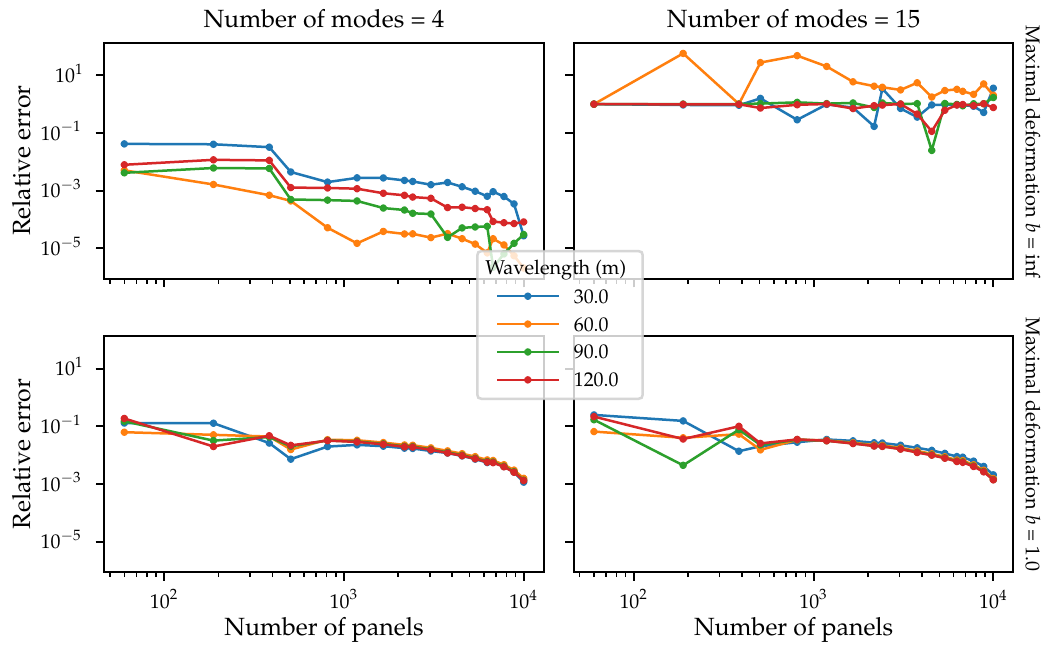
Figure 3. The relative error on the maximal absorption width computed with the first four modes and the first fifteen modes of the S3 with respect to a reference solution with 11850 panels, for several wavelengths and with and without constraint on the maximal deformation ( b → ∞ means no constraint). Table 1 gives the parameters of the